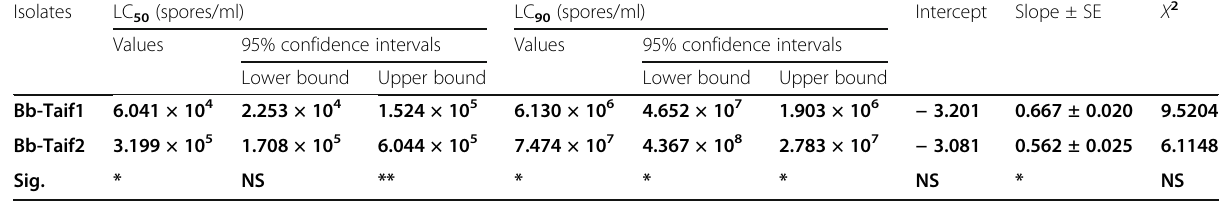
Table 1 Values of LC 50 and LC 90 with 95% confidence intervals of the two tested endophytic isolates of Beauveria bassiana on grapevine aphid, Aphis illinoisensis Isolates LC 50 (spores/ml) LC 90